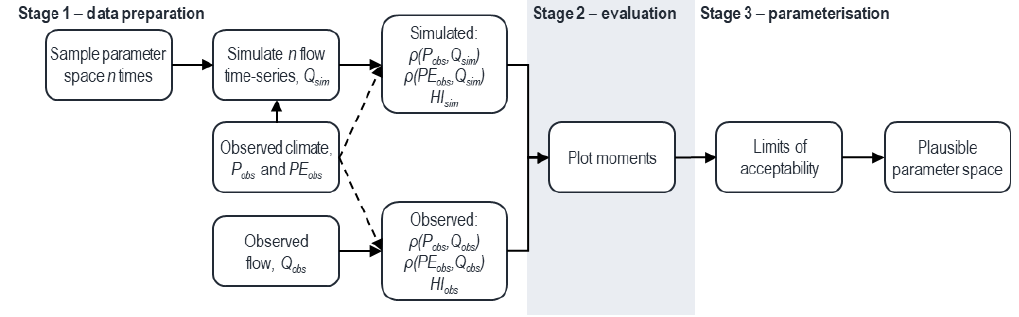
Figure 1. Overview of the three stages of the modified covariance approach to model parameterization.